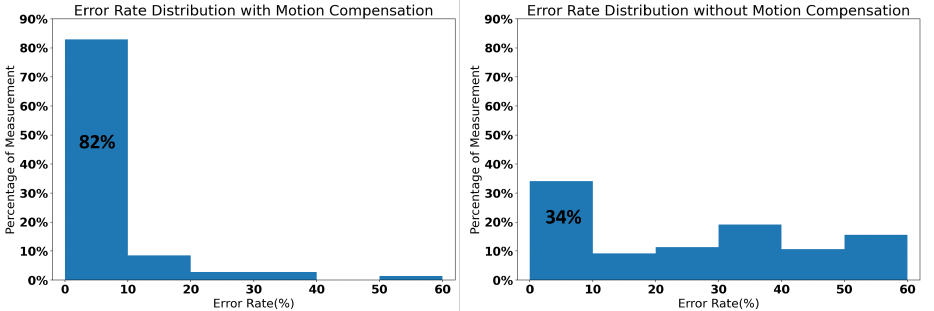
Figure 11. HR measurement error rate when participants sit in the passenger seat on the highway with motion compensation ( left ) and without motion compensation ( right ).